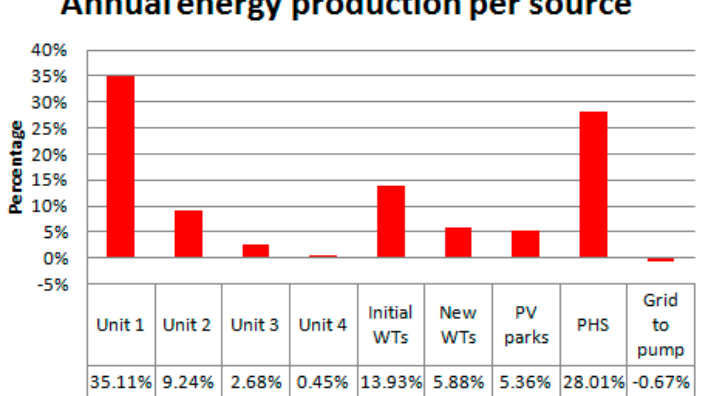
Figure 13. Annual energy production in Samos Island from different sources, considering hybrid power station operation ( P hydro = 10.5 MW).